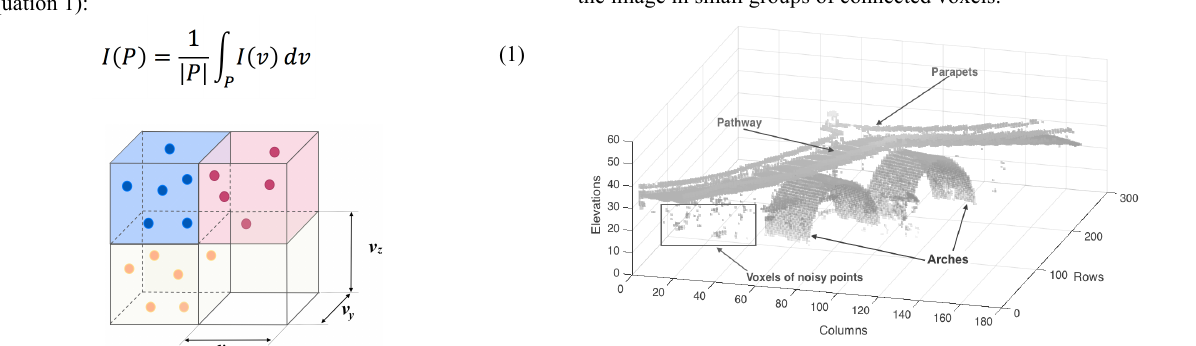
Figure 4. Voxel structure where the intensity of each element is computed from the colour of points contained in each element.